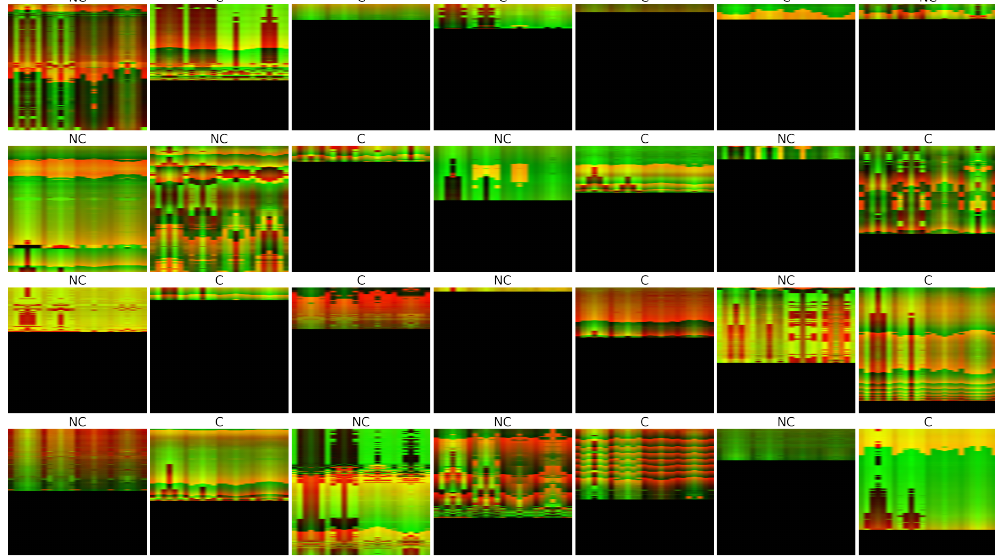
Figure 7. Twenty-eight different ground-truth sequences represented in a 3-dimensional (300,25,2)-shaped tensor after the TSSI normalization. The horizontal axis of each Tree Structure Skeleton Image (TSSI) sequence is the keypoints axis. The vertical axis of each TSSI sequence is the time axis. The x , y dimensions are mapped to RG(B) channels for visualization. The axes are kept fixed and the aspect is adjusted so that the data fit in the axes. Ground truth labels C/NC represent the Crossing or not Crossing future action of the